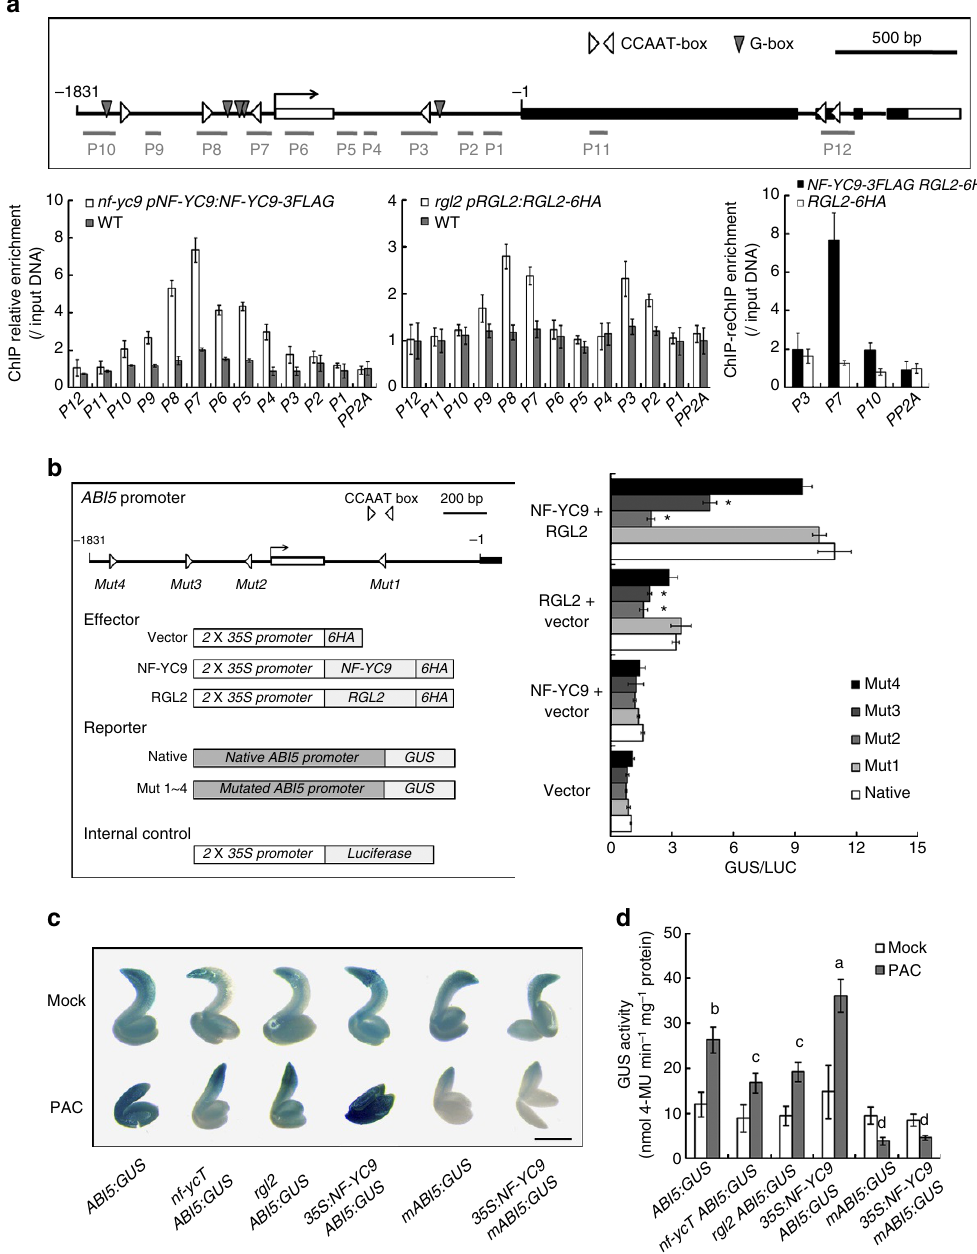
Figure 5 | NF-YCs and RGL2 synergistically regulate ABI5 expression by binding to the ABI5 promoter. ( a ) ChIP and ChIP-reChIP analyses of NF-YC9 and RGL2 binding to CCAAT-box containing region in ABI5 genes upon precipitation with anti-FLAG or/and anti-HA antibodies in the WT (wild-type, Col-0), nf-yc9 pNF-YC9:NF-Y9-3FLAG , rgl2 pRGL2:RGL2-6HA ( RGL2-6HA ) and rgl2 nf-yc9 pNF-YC9:NF-YC9-3FLAG pRGL2:RGL2-6HA ( NF-YC9-3FLAG RGL2-6HA ) lines. The seeds were grown on 1/2 MS medium containing 5 m M PAC for 12 HAS and harvested for further test. Relative enrichment fold was calculated by normalizing the amount of a target DNA fragment against that of a genomic fragment of a reference gene TUB8 , and then against the respective input DNA samples. The enrichment of a PP2A genomic fragment was used as the negative control (the same below). Data represent mean ± s.d. of biological triplicates. ( b ) Transient expression assays of ABI5 promoter activity modulated by NF-YC9 and RGL2 in Arabidopsis mesophyll protoplasts. Various constructs used in transient expression assays are shown in the left panel. Either ABI5:GUS (Native) or four mABI5:GUS (Mut1 B 4) were co-transformed with effectors or the empty vector (Vector) into Col mesophyll protoplasts. Relative GUS activity (GUS/Luciferase) that indicates the level of ABI5 expression activated by various effectors is shown in the right panel. Data represent mean ± s.d. of three biological replicates. Asterisks indicate significant changes of samples when compared with the relevant native sample (Student’s t -test, P o 0.05). ( c ) Representative GUS staining of mock (upper panel) and PAC treated (lower panel) seeds harbouring ABI5:GUS or its mutated version in various genetic backgrounds. The seeds were grown on 1/2 MS either containing 5 m M PAC or mock for 48 HAS. Scale bar, 0.5mm. ( d ) Quantitative analysis of GUS activity in the native and mutated ABI5:GUS seeds shown in c . Data represent mean ± s.d. from at least 100 seeds of each genotype. Statistically significant differences are indicated by different lower-case letters (Student’s t -test, P o